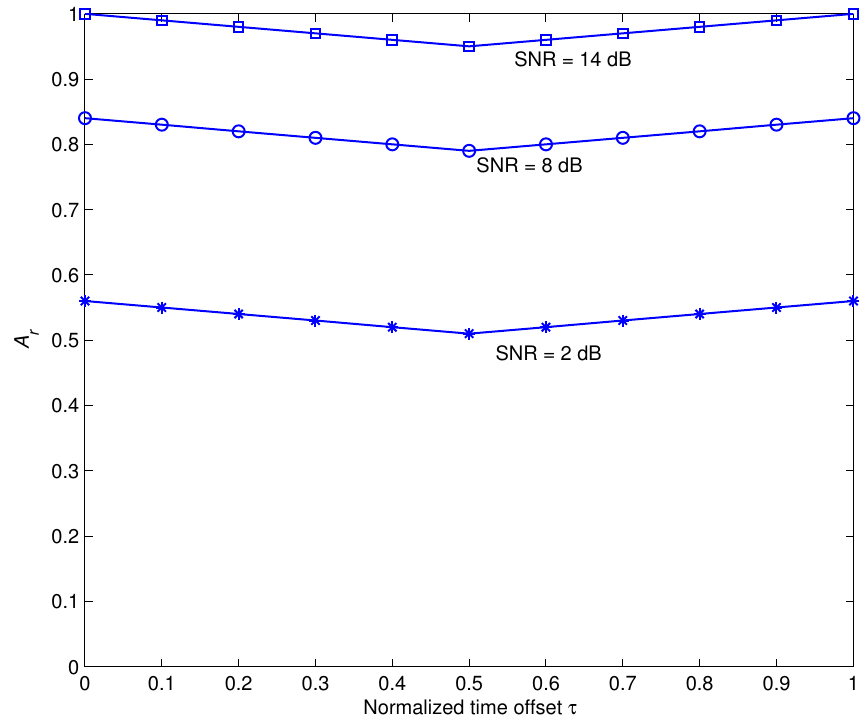
Figure 5. The impact of normalized time offset τ on the recognition